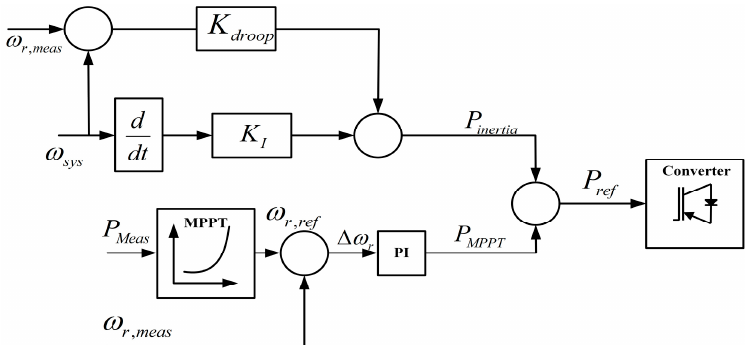
Figure 8. Inertia emulation control with droop control [18].